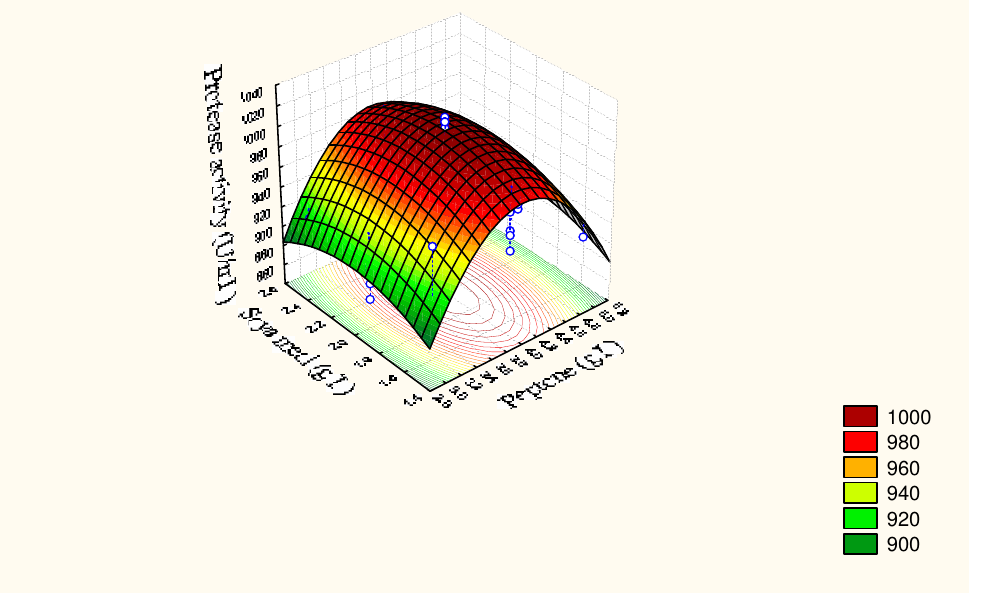
Figure 3(c). Effect of peptone & soya meal on protease activity